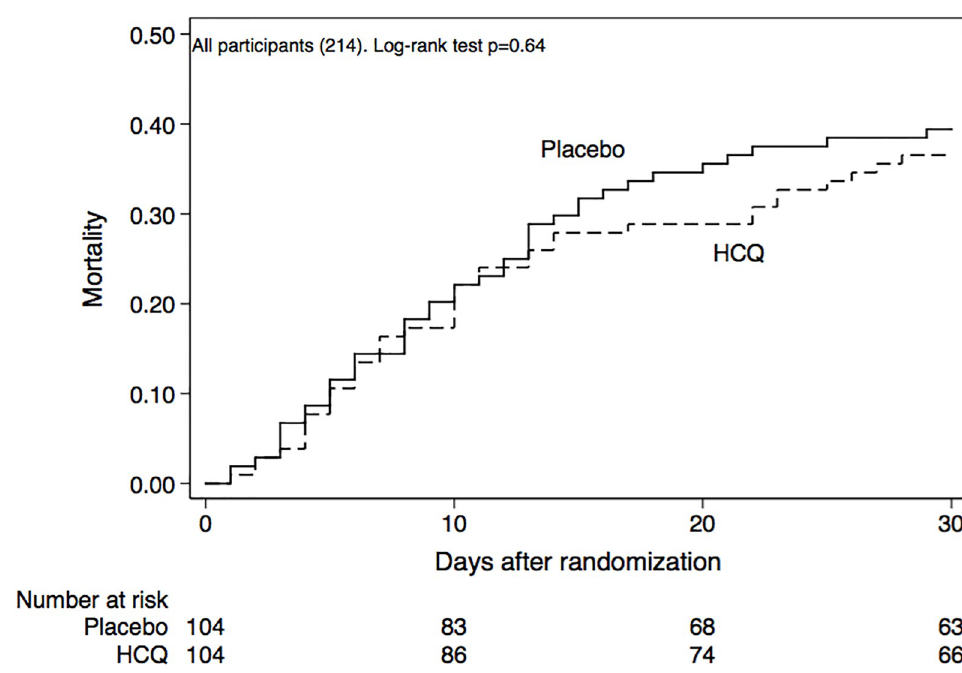
Fig 2. Time to death in participants, hydroxychloroquine (HCQ) group vs. placebo. Placebo (continuous line) vs HCQ (dashed line), with no significant difference by the log-rank test.